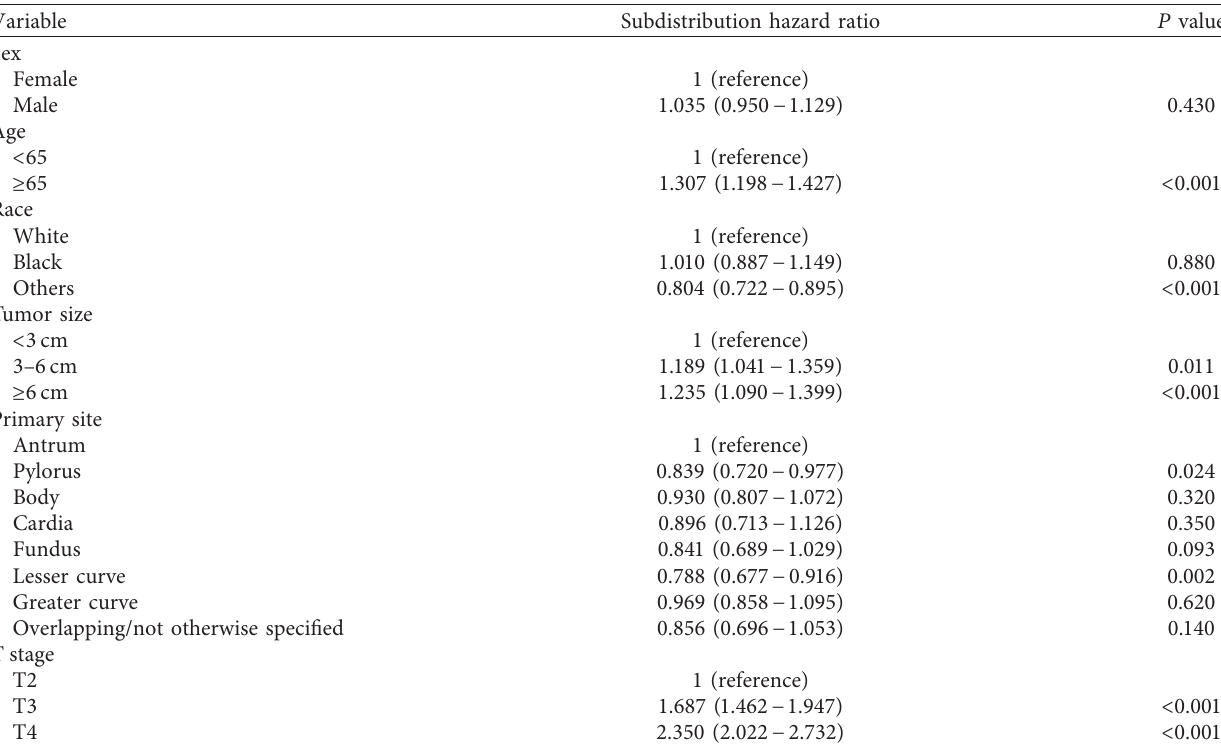
Table 6: Results of competing risks regression with inclusion of possible risk factors in patients with advanced gastric